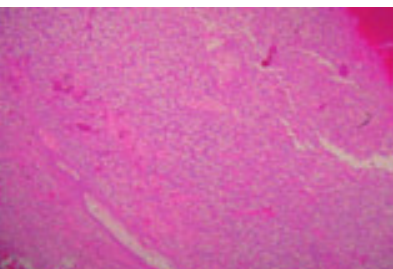
Figure 1. Vaginal metastases from renal cell carcinoma, clear cell type. Microscopic examination of the tumor from the vagina reveals the compact alveolar architecture of cells with clear cytoplasm and distinct cell boundaries in a background of delicate vasculature. (H&E stain; magnification 100X.)